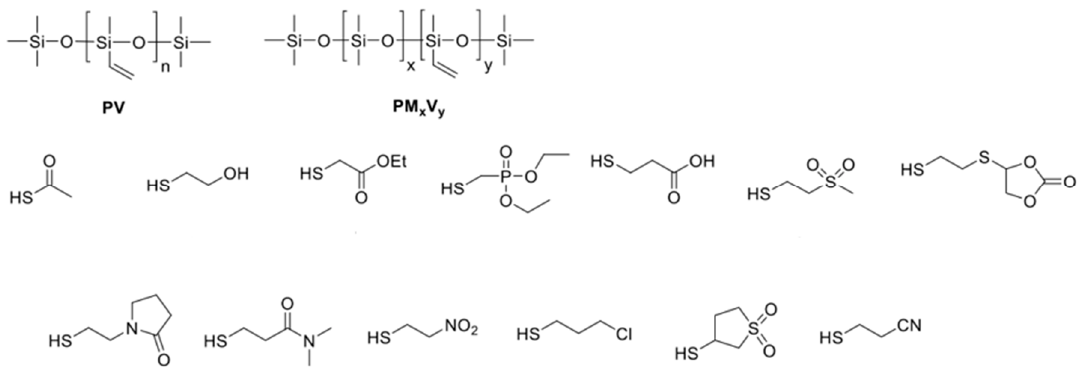
Figure 25. The modification of PSVin with thiols of various nature. Reprinted/adapted with permis- sion from Ref.